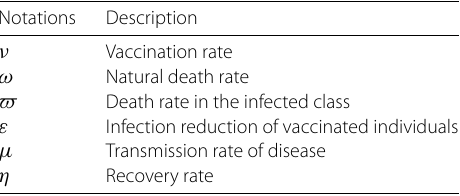
Table 1 Description of the parameter described in the provided Model